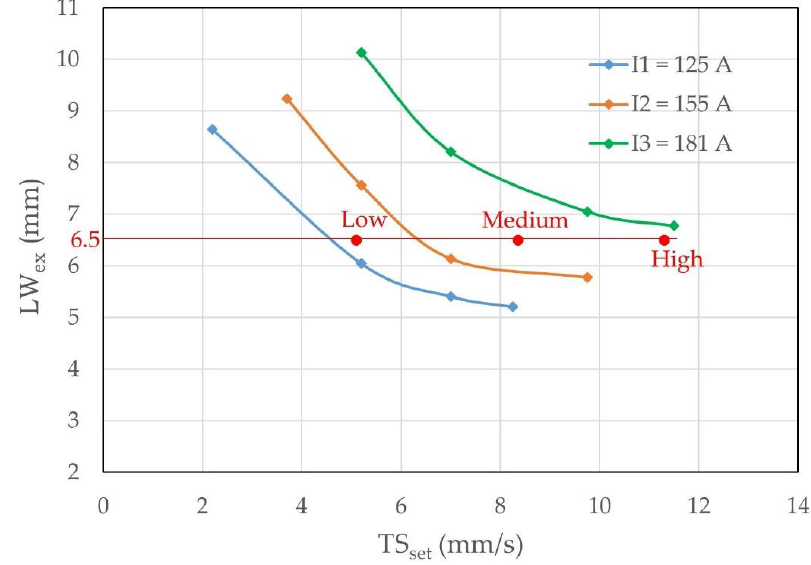
19 of 21 Figure 21. Surface plot of SW index for the working envelope. 3.4. Operational Map Validation The validation of the operational map was carried out over the two geometric responses (maximum external LW and minimum effective LW) and the surface waviness index. With this purpose, three parameter conditions (TS and I) were randomly chosen inside the working envelopes,